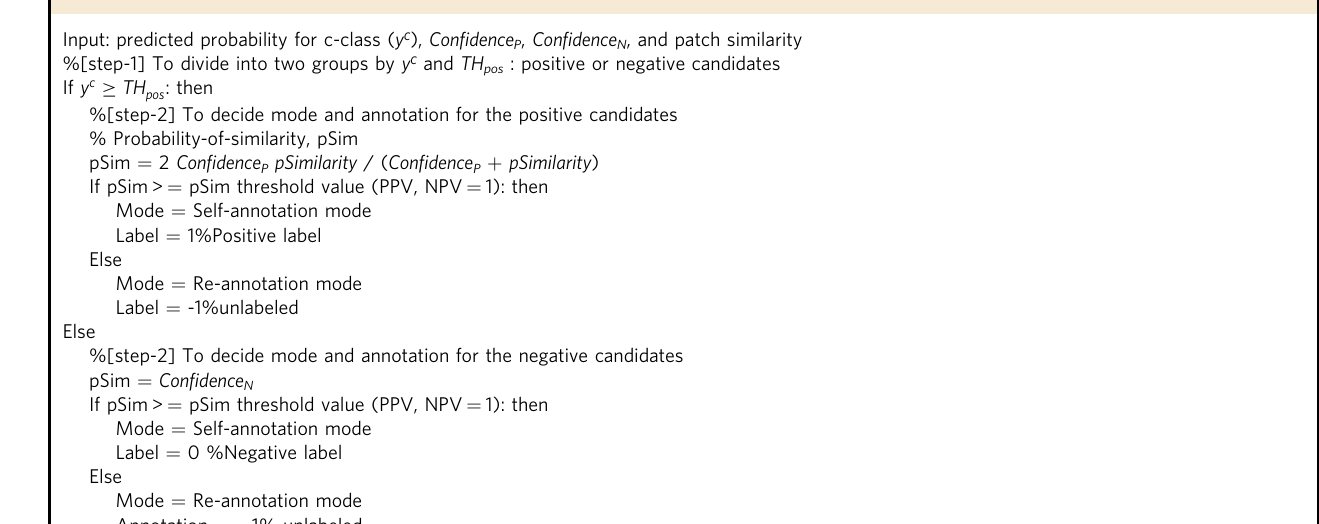
Box 1 | Mode selection for automated labeling